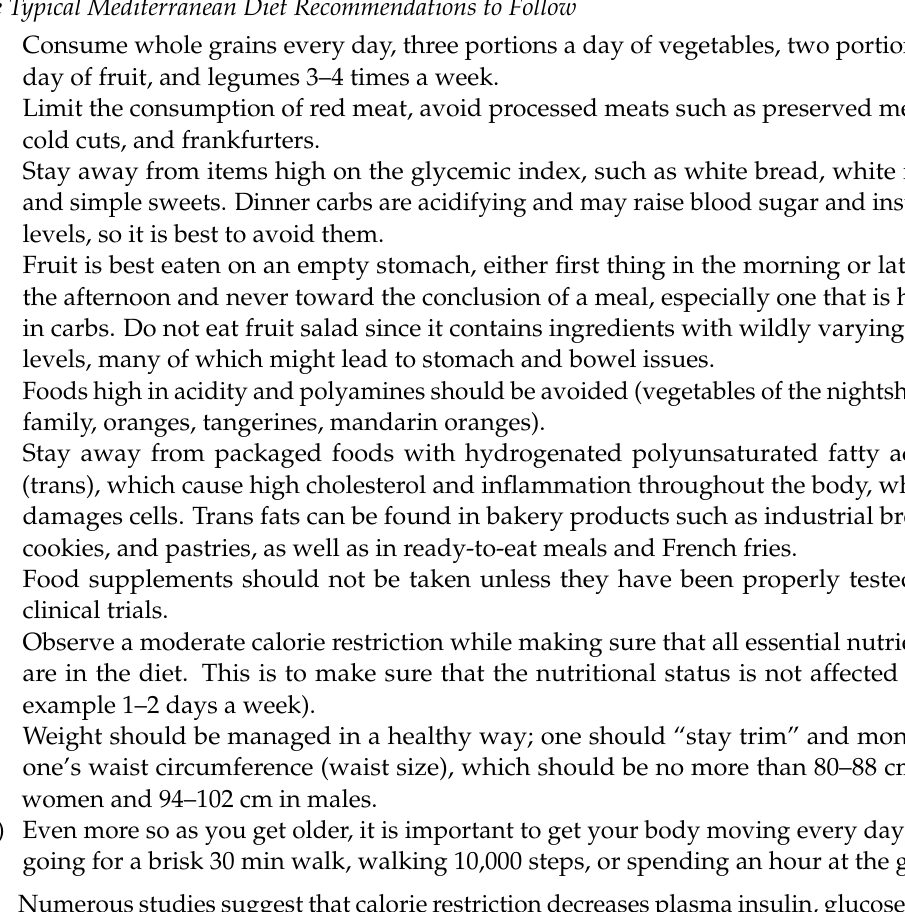
Figure 2. The typical Mediterranean diet and lifestyle raccomandations to follow: Mediterranean Lifestyle.